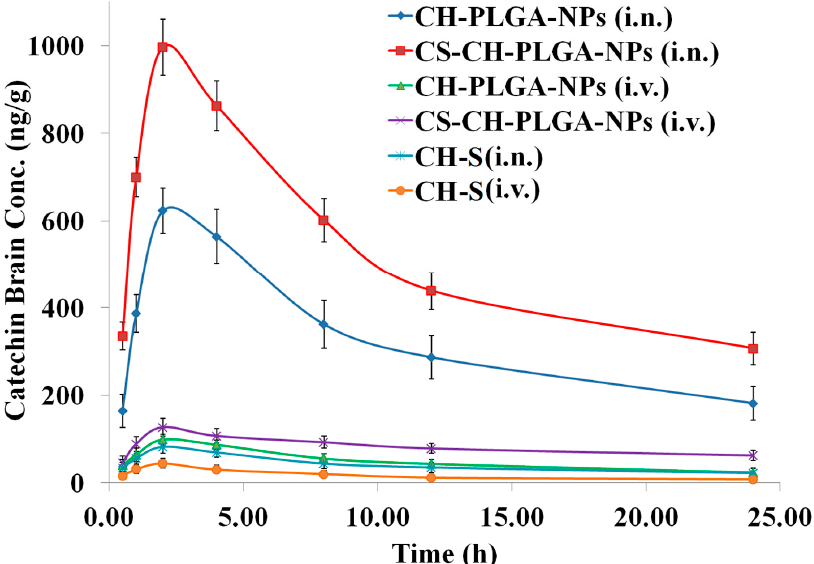
Figure 12. Pharmacokinetic profiles of catechin hydrate (CH) concentration in the brain at different time intervals after administration of optimized different nanoformulations compared with pure catechin hydrate (CH). Table 9. Pharmacokinetics (PKs) of catechin hydrate after i.n. and i.v. administration to rats at the dose of 10 mg kg − 1 in the brain, lungs, and plasma ( n = 6, mean ± SD). AUC, area under curve.